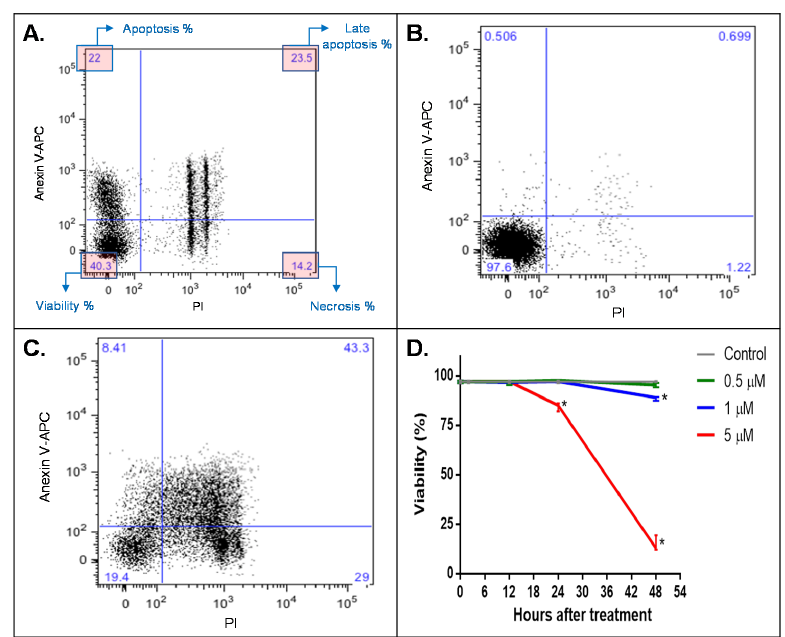
Figure 5. Biological activity of the CYN-certified standard (Abraxis ® ) on HepG2 cells, analyzed by